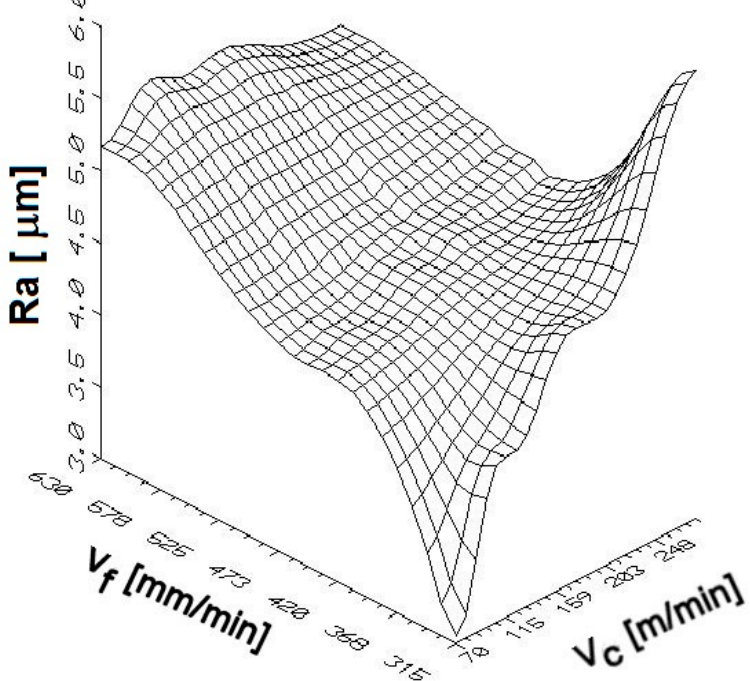
Figure 13. Surface topography in ball end milling process as a function of feed speed and cutting speed.